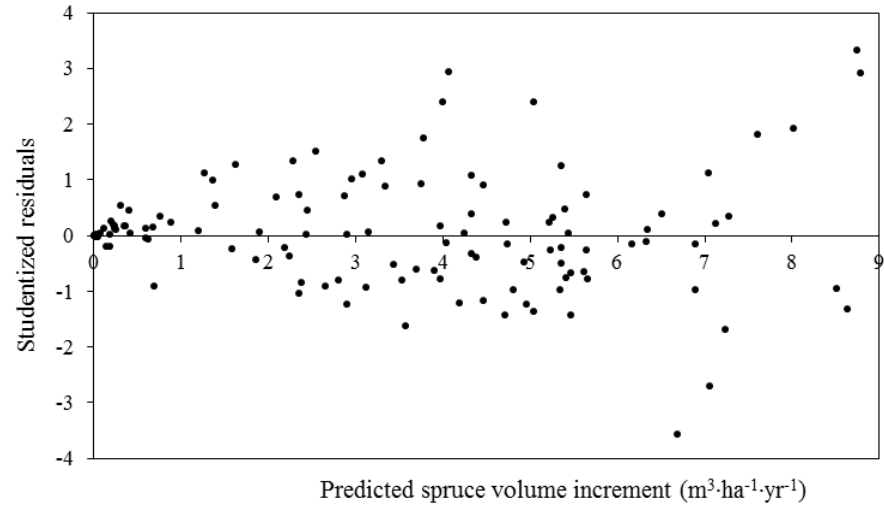
Figure 3. Residuals for the best model of spruce volume periodic annual increment. PAIV sw = β 0 × SDI dyswβ1 × SDI dydβ2 × HT swβ3 × HT awβ4 .